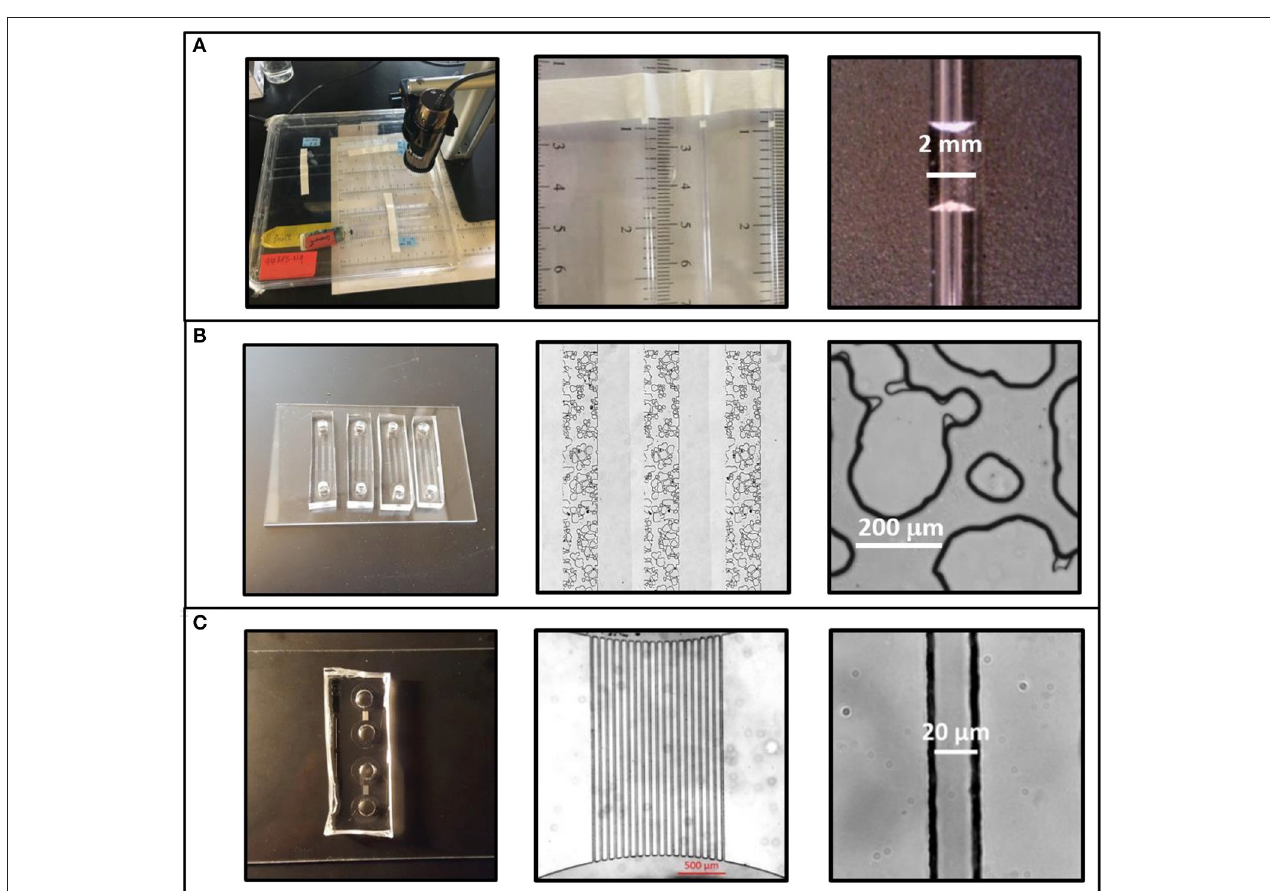
FIGURE 1 | Three experimental systems were used to test the effects of physical geometry on extracellular polymeric substance (EPS)-mediated drying behavior. (A) Intrinsic moisture retention behavior was measured in a macroscale regime using glass capillaries with an internal diameter of 1.2 ± 0.01mm. (B) Drying behavior in soil-like geometries was measured using emulated soil micromodels. This systems features a 1mm × 10mm × 35 µ m (w:l:h) microstructured region with a physical geometry similar to aggregated sandy loam soil. Pore widths range from 10 µ m to > 300 µ m. (C) Microcapillary arrays were used for high-throughput determination